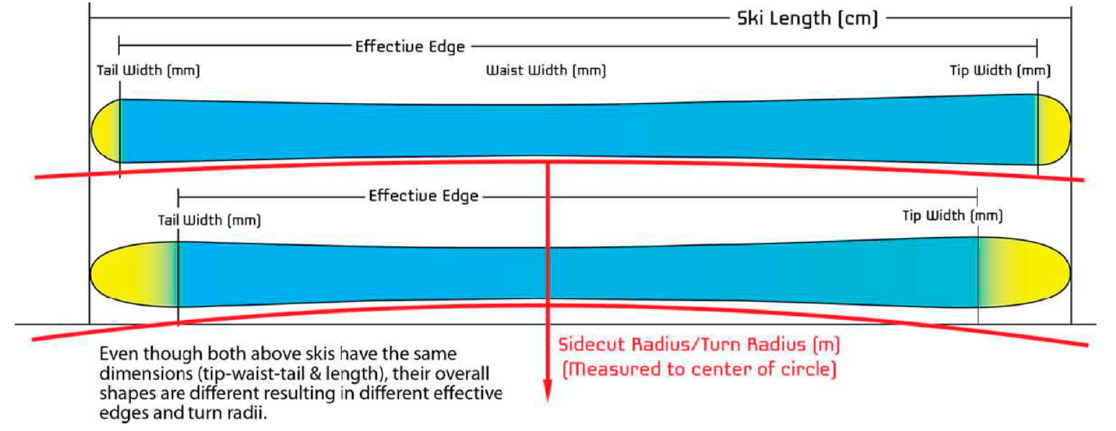
Figure 1. Ski geometry characteristics (ski length, side-cut radius, and widths of the tip, waist and tail of the ski). With permission from https://www.gearx.com/blog/knowledge/skiing/ski-shape- profile/, accessed on 2 September 2022.